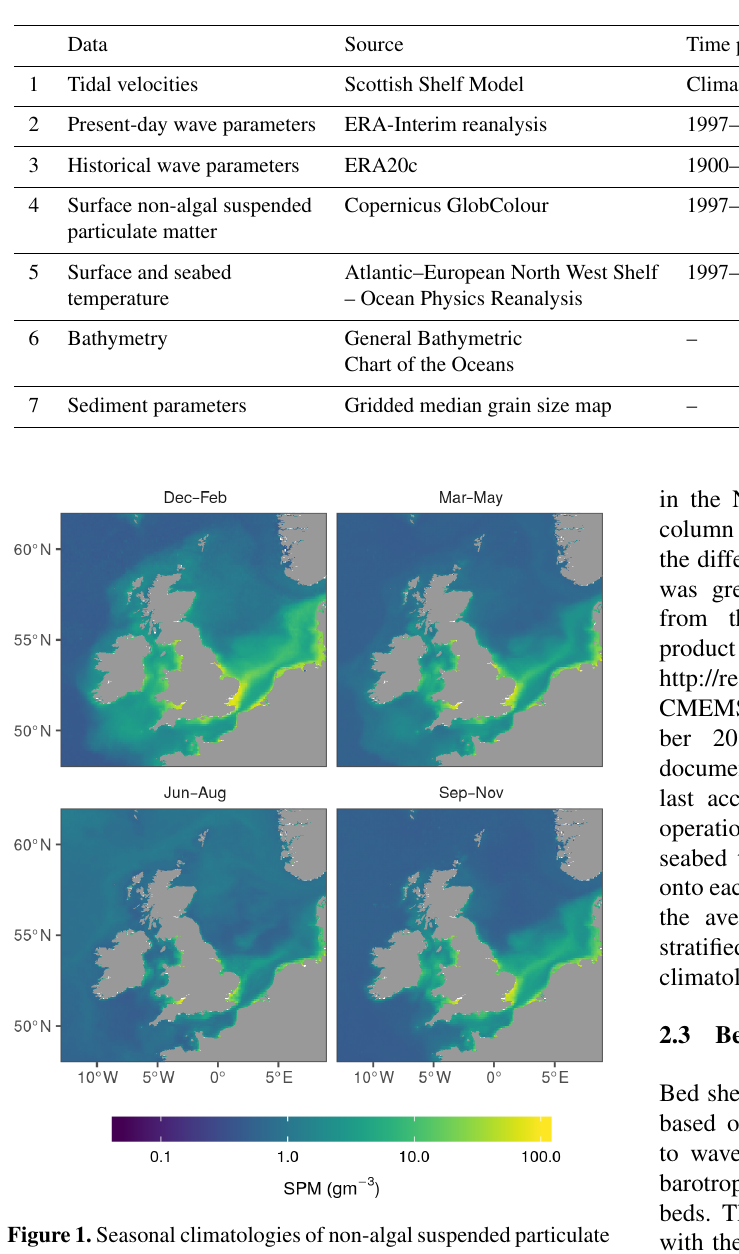
Table 1. Data used for the calculation of bed shear stress and stratification indices over the time periods 1997–2017 and 1900–2010. Calcu- lations were made at a spatial resolution of 0 . 125 ◦ × 0 . 125 ◦ , and all data were available at that or finer resolution.